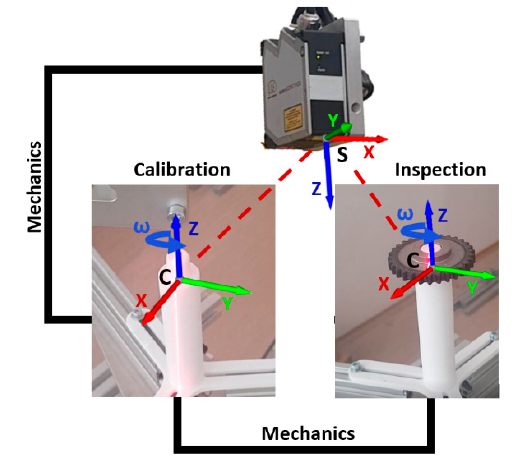
Figure 3. The reference systems for calibration: S—Sensor (unprocessed point cloud), C—fixation